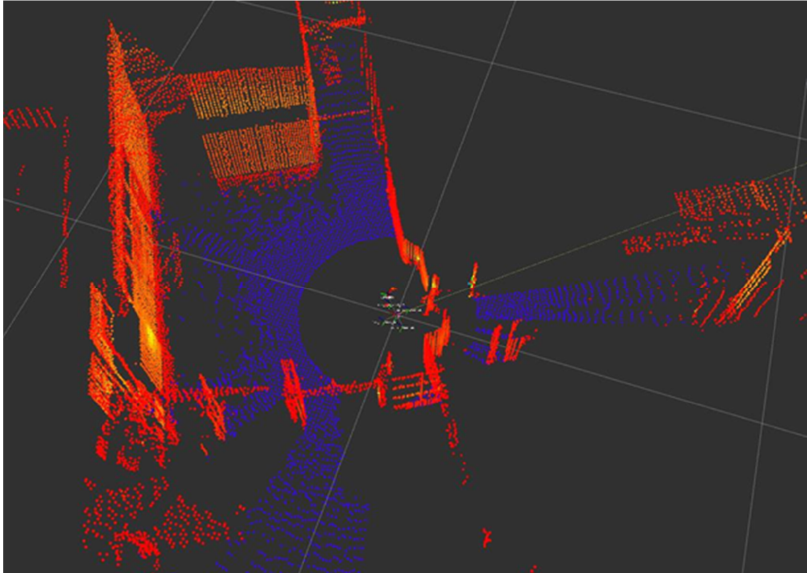
Figure 5. Laser scan in the corridor of the B-building of the Offenburg University of Applied Sciences. (Blue: floor area detected by the floor_detection node, red: remaining laser scan points). Hdl_graph_slam Node